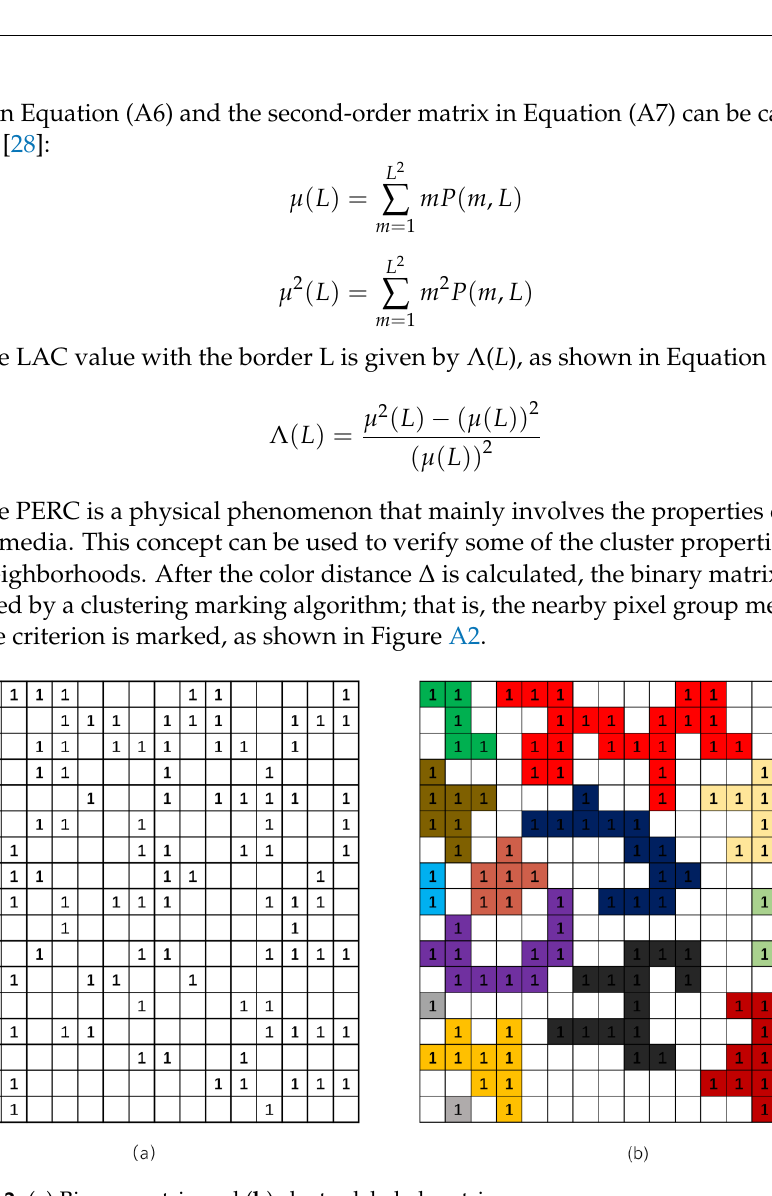
Figure A2. ( a ) Binary matrix and ( b ) cluster-labeled